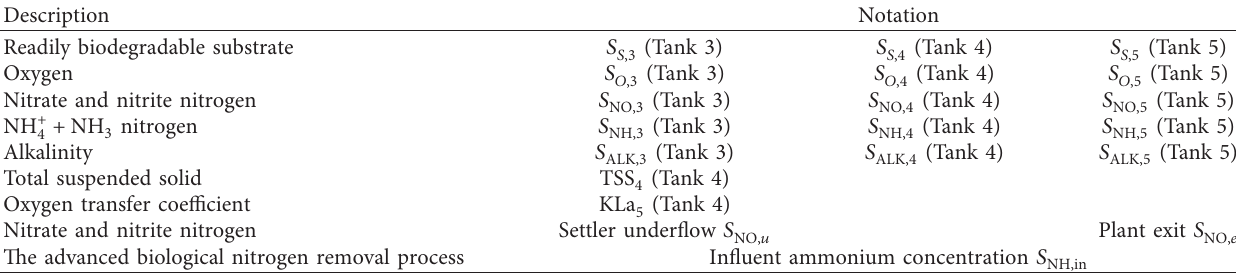
Table 6: Description and notation of the monitoring variables.